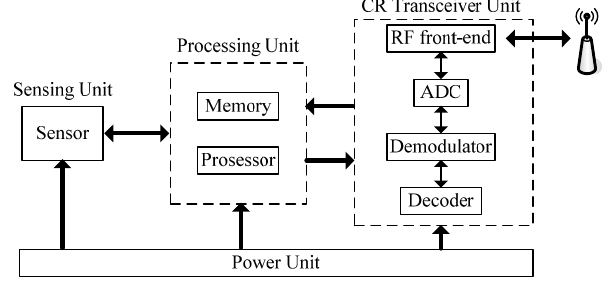
Figure 2. Hardware structure of a CR-WSN sensor node.